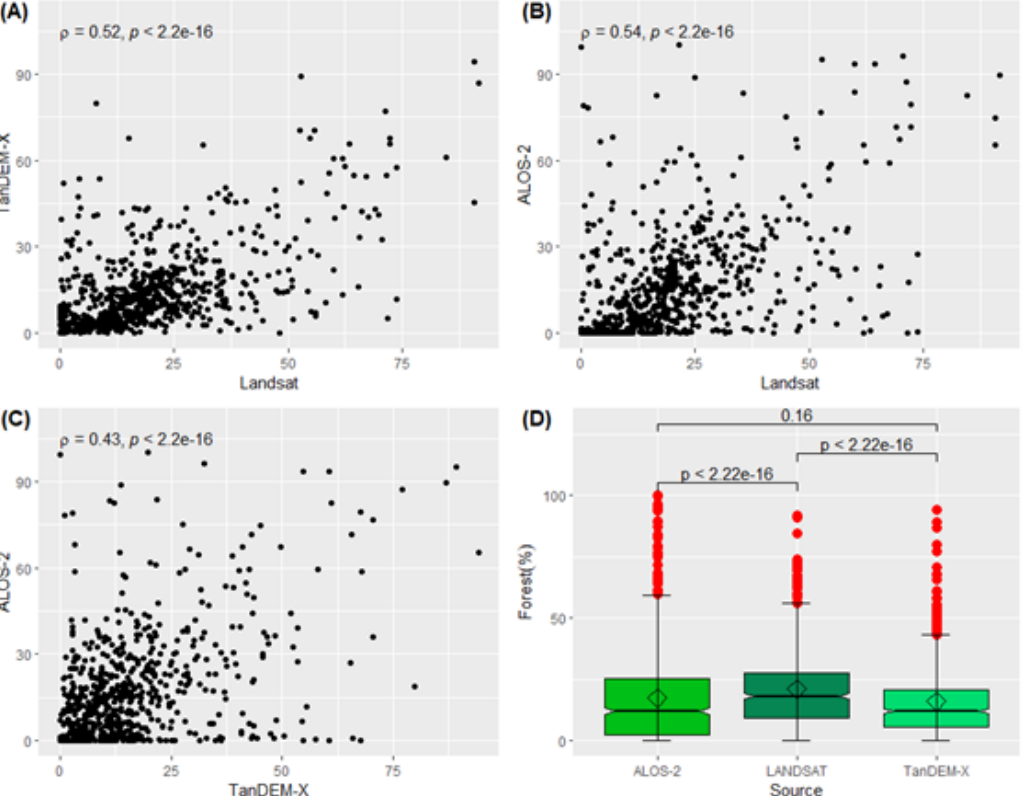
Figure 12. Relationship between the percentages of forest estimations obtained by the TanDEM-X, ALOS-2, and Landsat 8 OLI image interpretation ( A – C ) and the results of Wilcoxon test ( D ) over the Cerrado biome at the local level (image